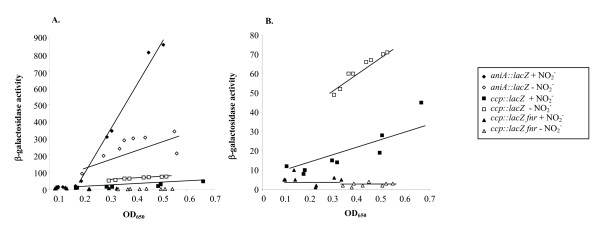
A. β-galactosidase activity of the aniA::lacZ and ccp::lacZ fusions. Strains RUG7001 (aniA::lacZ), JCGC201 (ccp::lacZ), and JCGC202 (ccp::lacZ fnr) were grown in liquid culture with or without 5 mM NaNO2. Samples were taken at hourly intervals, β-galactosidase activity measured, and the β-galactosidase activities plotted against optical density at 650 nm. B. Data for the JCGC201 (ccp::lacZ) and JCGC202 (ccp::lacZ fnr) fusions are shown on an expanded scale to illustrate more clearly the effects of FNR and nitrite on ccp expression.